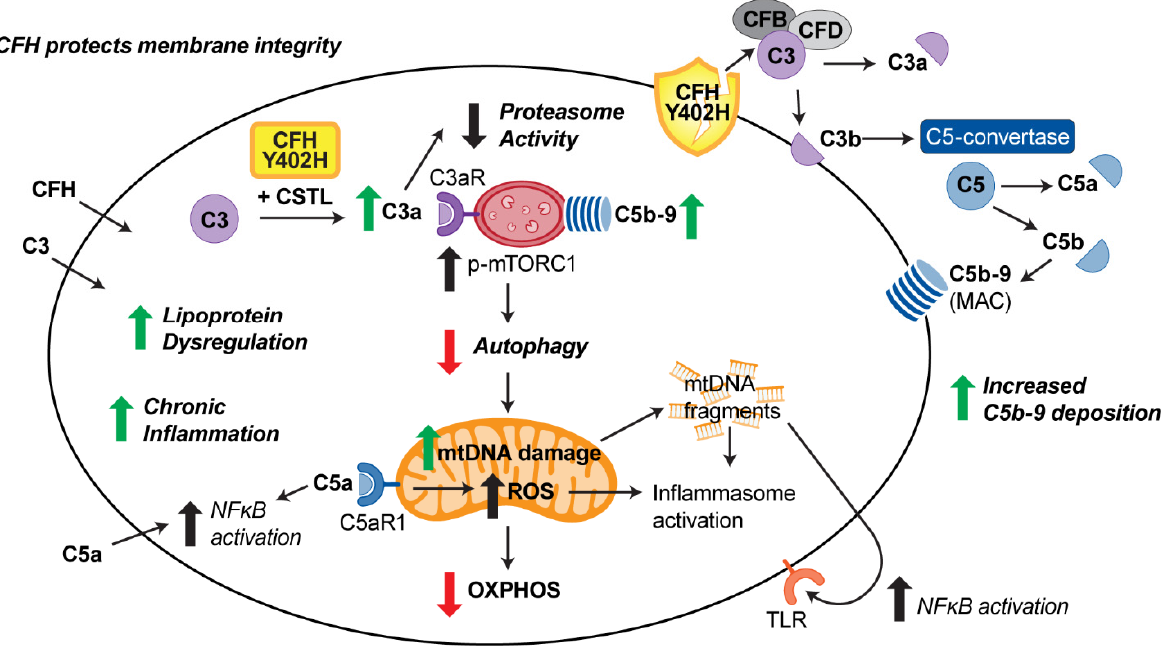
Figure 6. Model of CFH regulation of RPE function and putative genotype-specific effects. Extracellular CFH protects cell membranes and inhibits C3 conversion and subsequent deposition of the MAC complex. Intracellular complement can regulate pathways involved in degradation (proteasome and lysosome/autophagy) and mitochondrial homeostasis. (Green and red arrows indicate Y402H-dependent changes). In Y402H iPSC-RPE, enhanced C3a turnover, increased C5b9 internalization with lysosomal deposition, and reduced autophagy disrupts degradation of protein aggregates and damaged organelles. Reduced oxidative phosphorylation and increased mtDNA damage indicates a disruption in mitochondrial homeostasis. Accumulation of lipoprotein and increased inflammation further exacerbates RPE dysfunction.